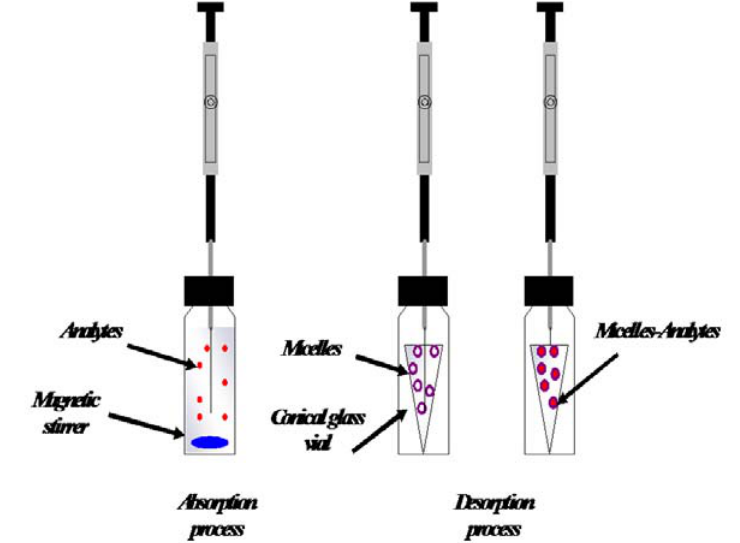
Figure 2 . Scheme of solid-phase microextraction with micellar desorption (from Ref.